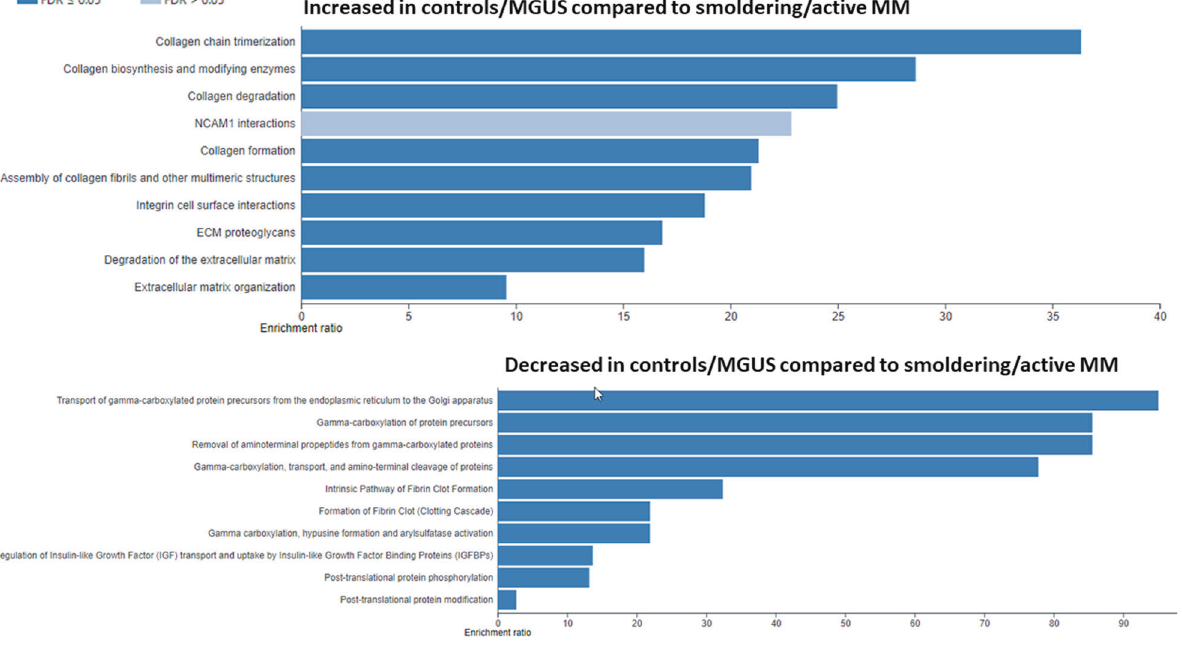
Fig. 2 Proteomic differences between patients with low and high plasma cell burden. A WebGestalt analysis of all proteins differentially expressed between controls/MGUS and smoldering active multiple myeloma using the Reactome pathway and presenting the top 10 pathways. MM multiple